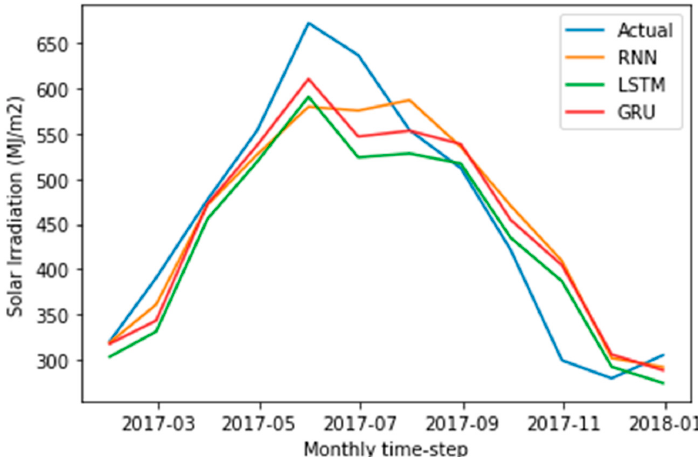
Figure 13. Comparison of RNN and its extensions in monthly time steps for Busan Region.